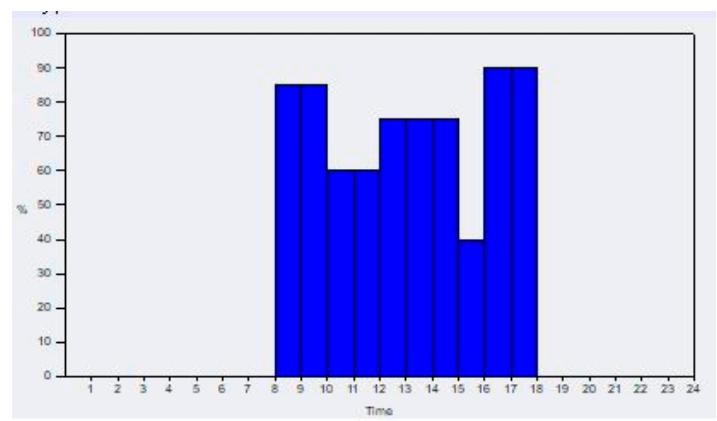
Figure A8. Wednesday Occupancy Pattern (input to BES).